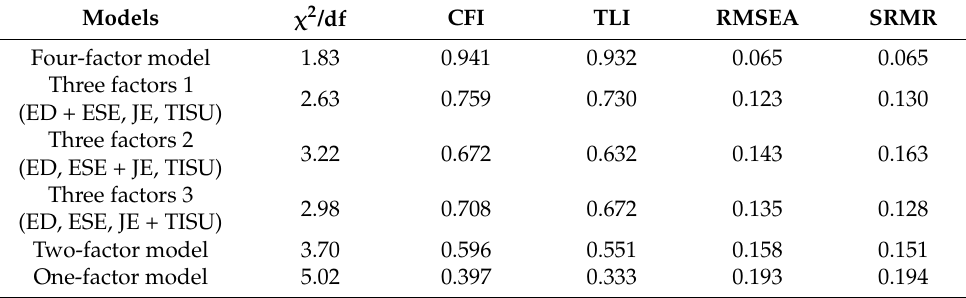
Table 1. Confirmatory factor analysis for discriminant